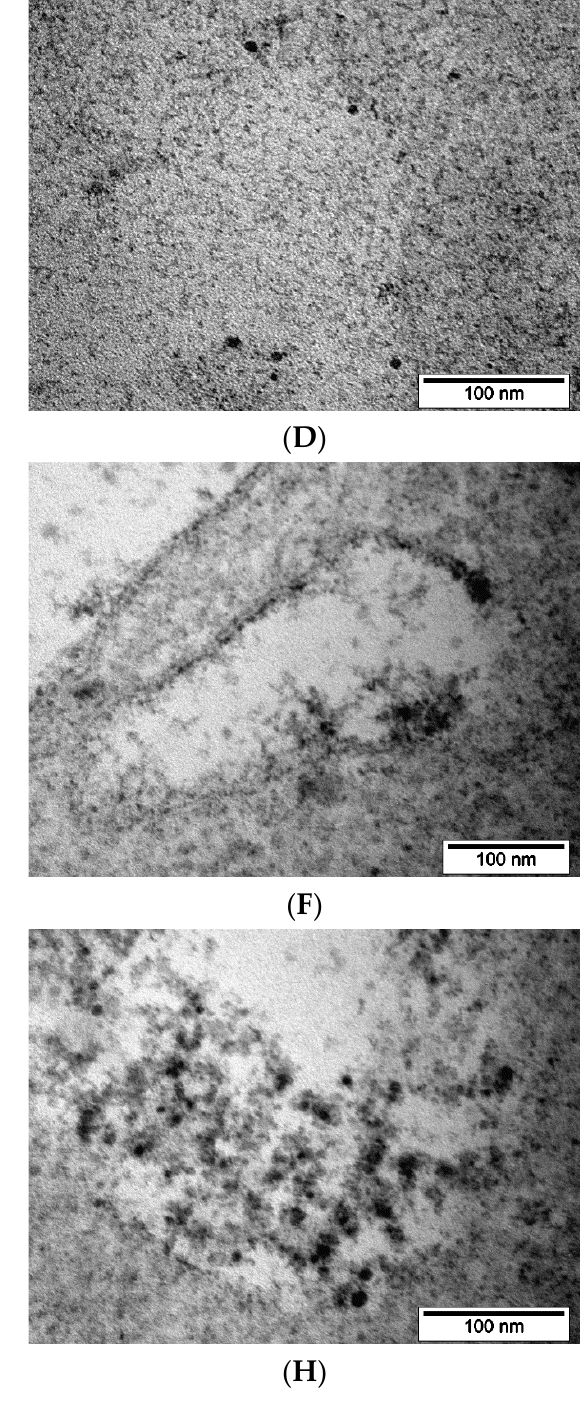
Figure 7. TEM images of the PC-3 cells after 2 h incubation with MNP-SS ( A – D ) or MNP-PEG ( E – H ): ( A ) — outer cell membrane has formed a vesicle around a group of MNP-SS nanoparticles; the group is enlarged in ( B , C ) — outer membrane and a cytoplasm of the PC-3 cell with attached clumps of MNP-SS nanoparticles and formed vesicle filled with nanoparticles; the vesicle is enlarged in ( D , E , G ) — PC-3 cells cytoplasm and plasmalemma with MNP-PEG nanoparticles, correspondingly; ( F , H ) — enlarged parts of E and G, correspondingly. The same results were obtained with 4T1 cells: after 2 h of incubation, MNP-SS na- noparticles were easily found on plasmalemma as well as in vesicles (Figure 8A – D), but